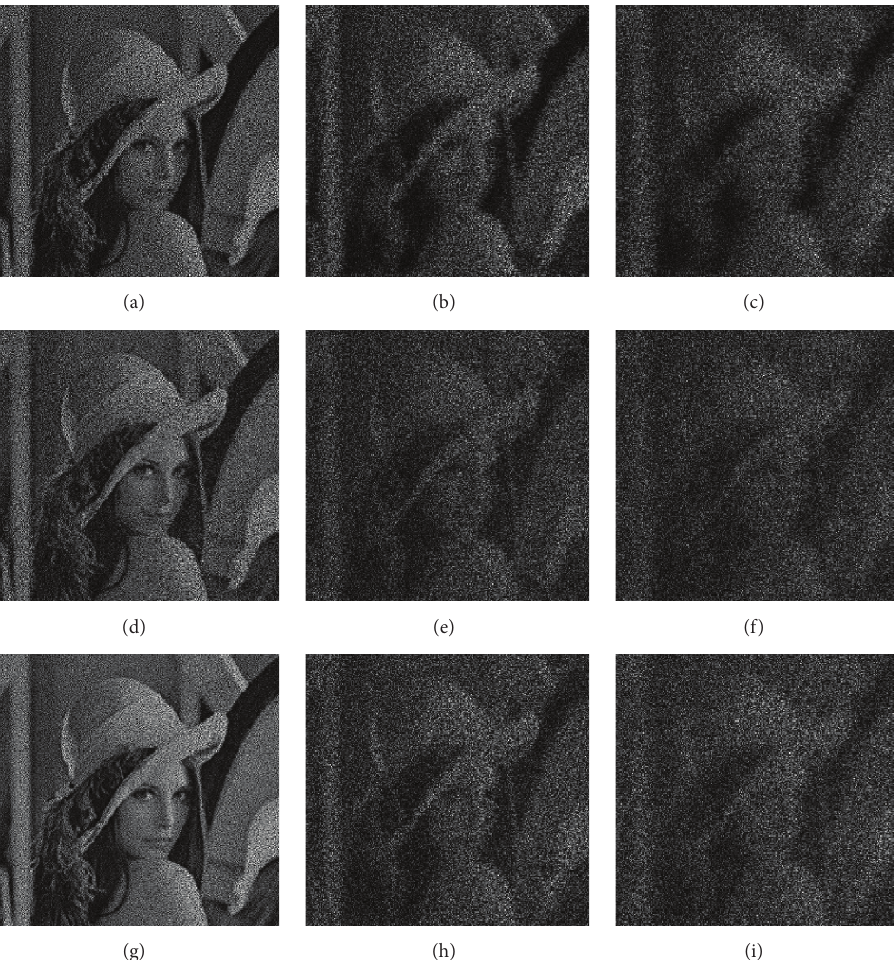
Figure 6: Results with incorrect parameters of FrT: (a–c) decrypted images with incorrect values of 𝑧 1 = 25.3 , 26, and 27 mm, (d–f) decrypted images with incorrect values of 𝑧 2 = 35.3 , 36, and 37 mm, and (g–i) decrypted images with variation in 𝜆 𝑝 by 10, 20, and 40